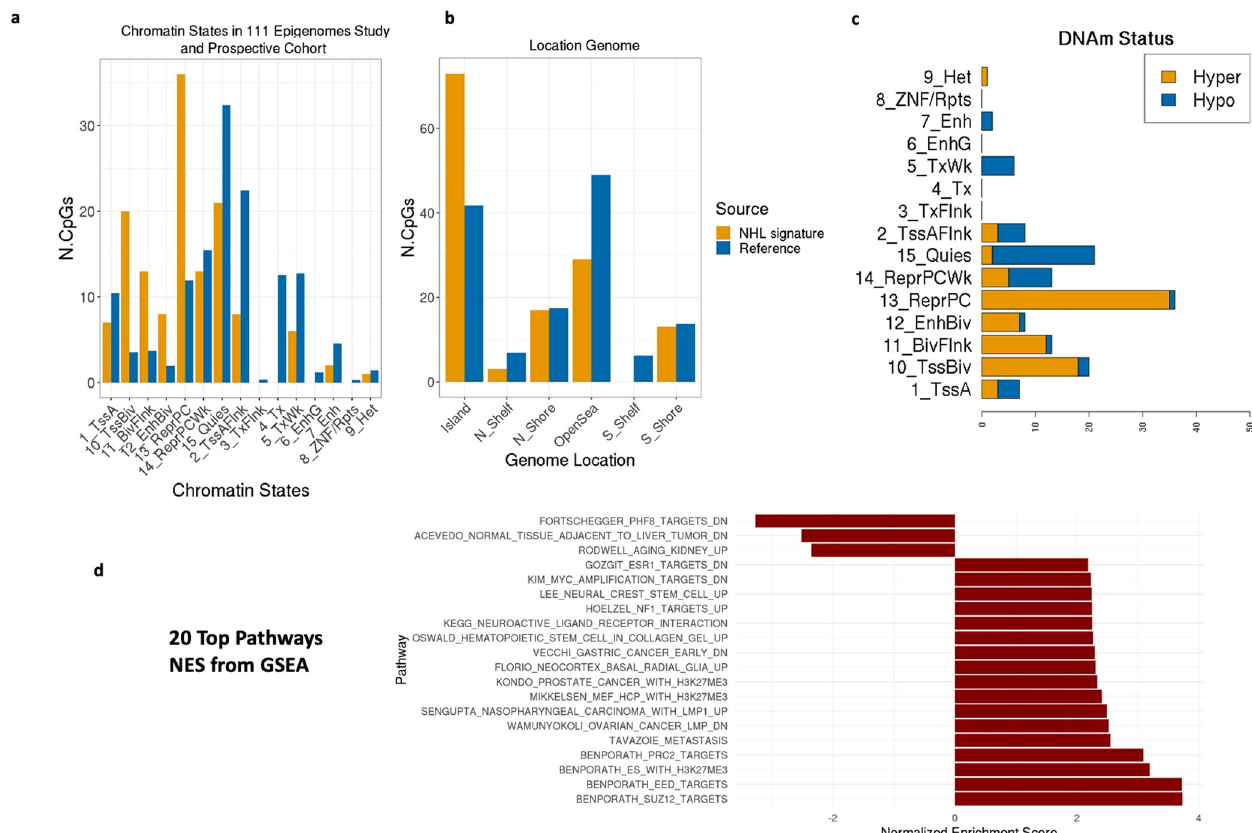
Fig. 4 Landscape of the future NHL signature. a Number of CpGs from the signature from each chromatin state compared to the annotated genome. b Location of the CpGs from the signature compared to the annotated genome. c Number of hyper-/hypo-methylated CpGs from the signature from each chromatin state within the prospective cohort (reference: healthy controls from the prospective study). d Top 20 pathways from GSEA analysis (C2-curated gene